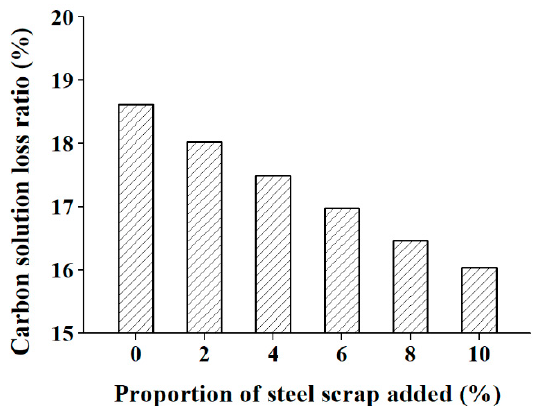
Figure 9. Carbon solution loss ratio at di ff erent amounts of steel scrap added.